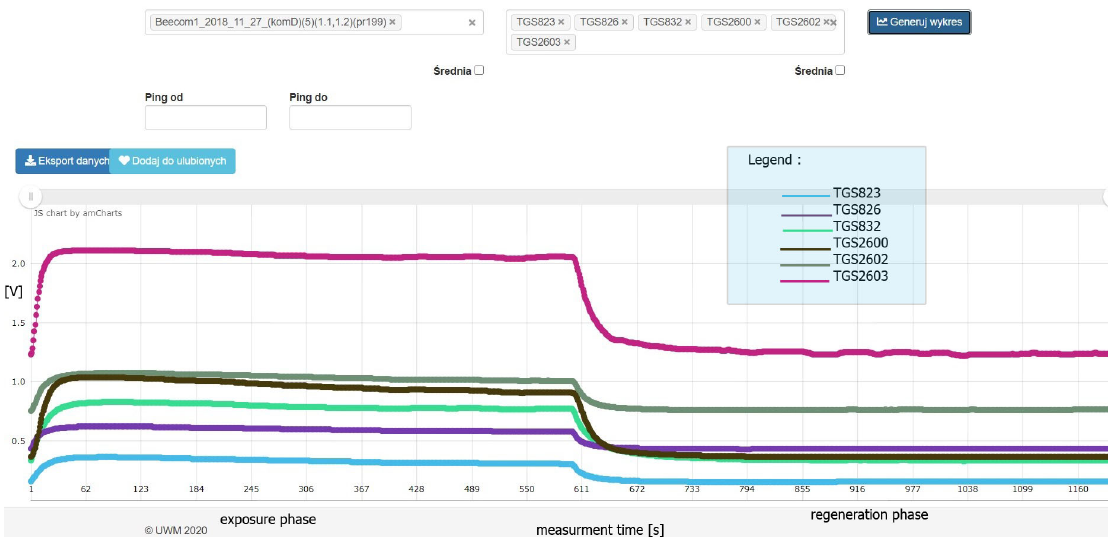
Figure 6. A sample graph illustrating the process of measurement. In this case, the measurement concerned a colony of P. l. larvae 6 days after culture in a wooden